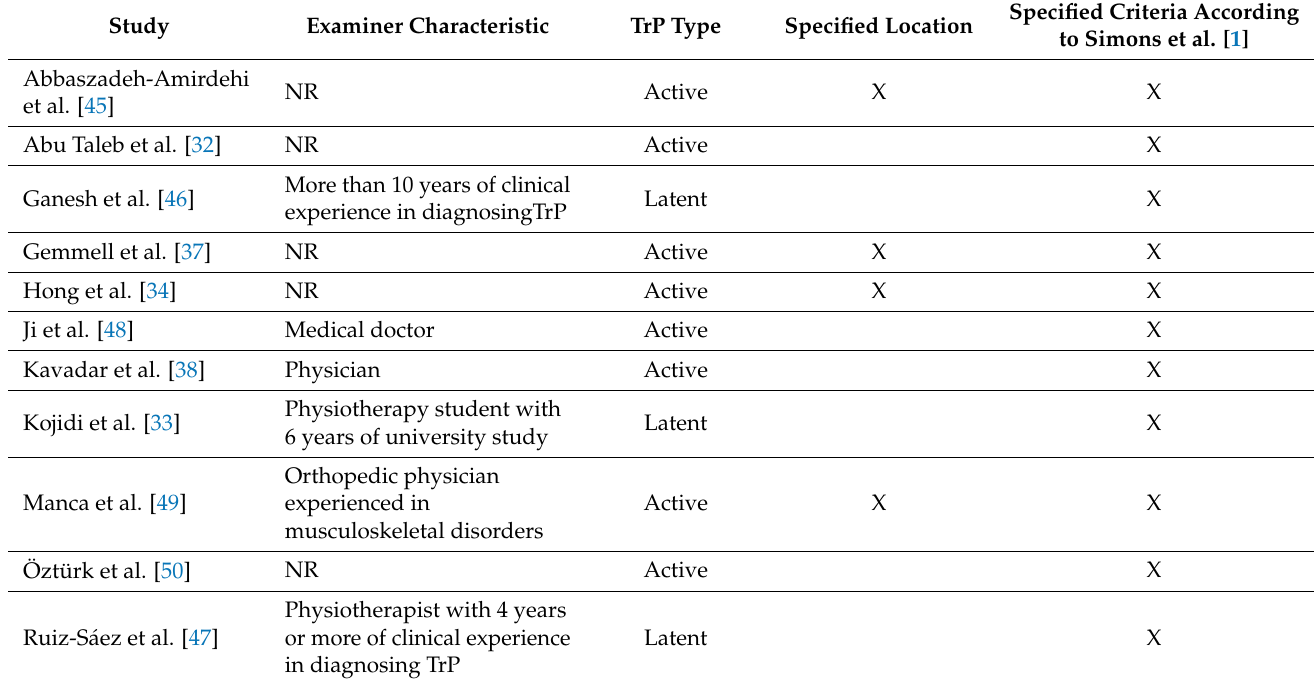
Table 3. Characteristics of examination of the upper trapezius muscle.